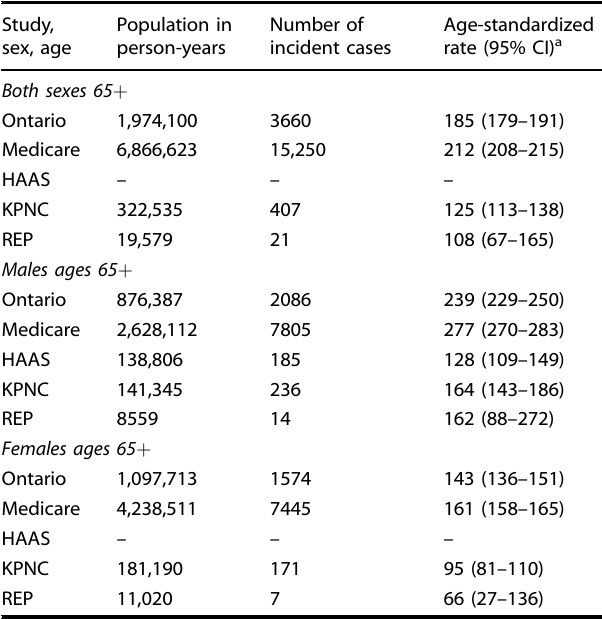
Table 1. Incidence of Parkinson disease by study, sex, among adults ages 65 and older.